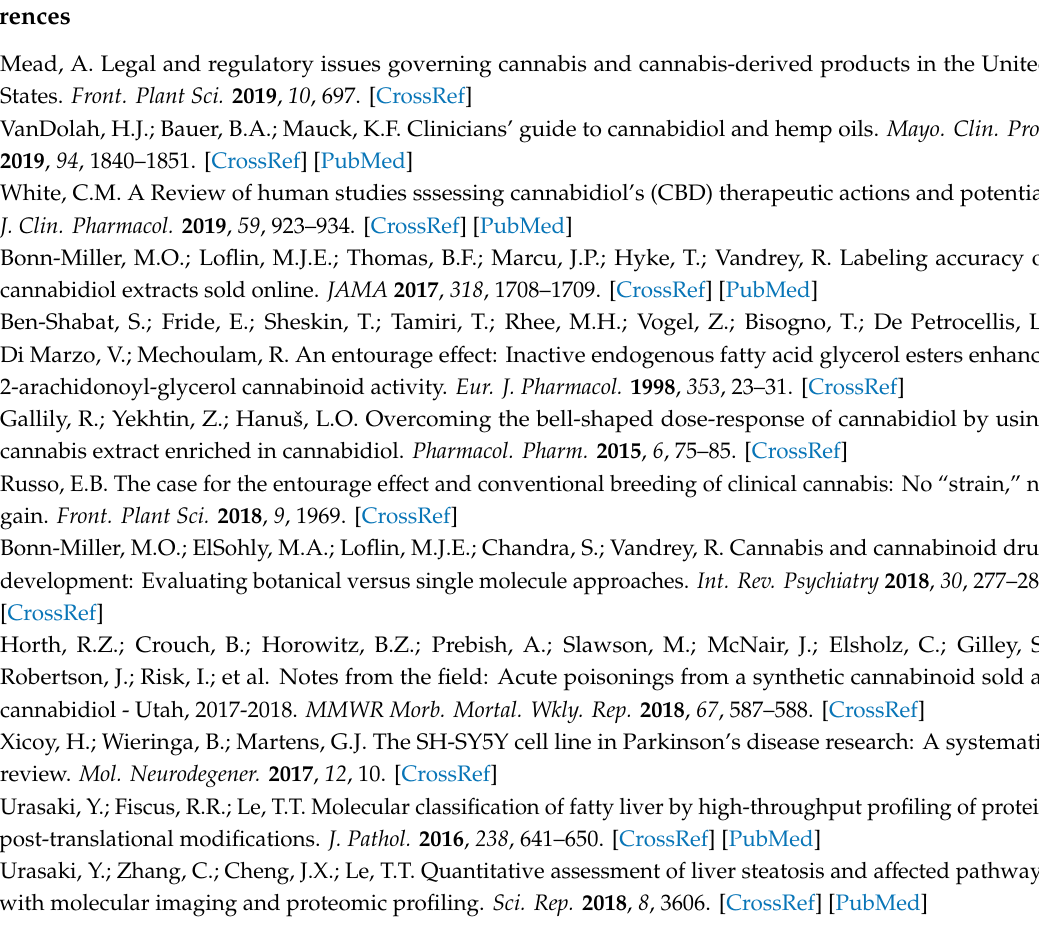
Supplemental Figure S1: Measuring the e ff ects of isolated CBD and CBD oils on the expression and phosphorylation of Akt isoforms, Supplemental Figure S2: Loading controls for cIEF immunoassays, Supplemental Figure S3: Dose-dependent e ff ects of CBD oil V1 on the expression and phosphorylation of Akt isoforms, Supplemental Figure S4: Time-dependent e ff ects of CBD oil V1 on the expression and phosphorylation of Akt isoforms, Supplemental Figure S5: Proteomic profiling of the e ff ects of CBD oil V1 with multiplexed cIEF immunoassays, Supplemental Figure S6: Expression of protein isoforms in selected signaling pathways following treatment with isolated CBD and CBD oil V4, Supplemental Table S1: List of primary and secondary antibodies, Supplemental Table S2: List of biomarker proteins and their functions and supplemental data on the chemical composition of the CBD